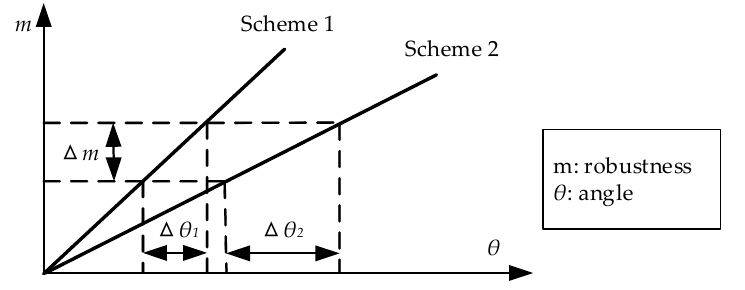
Figure 13. Comparison of design rigidity between scheme 1 and scheme 2.